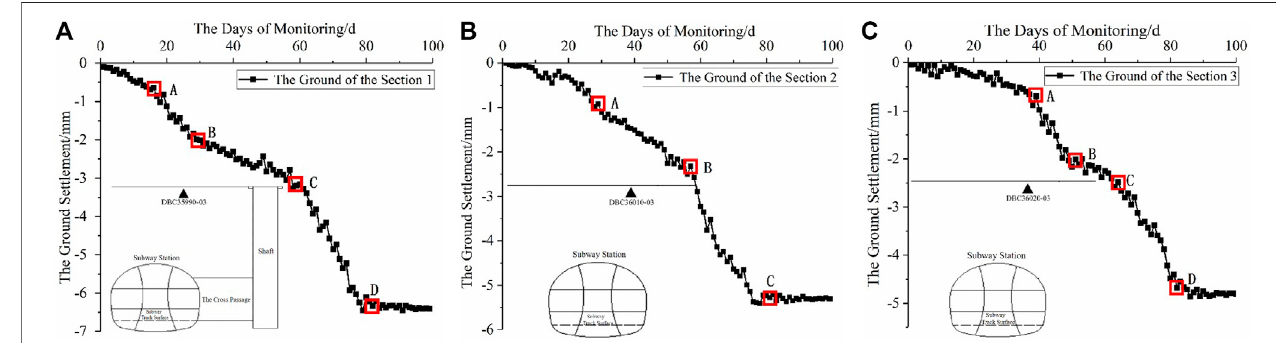
FIGURE 9 | Variation of ground displacement of: (A) Section 1 , (B) Section 2 , and (C) Section 3 .